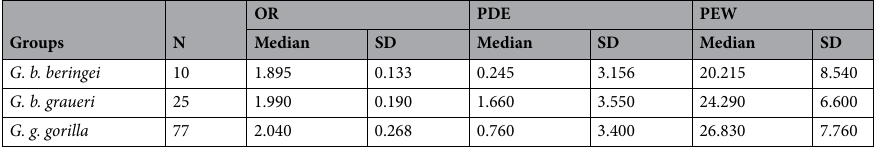
Table 3. Summary statistics (median and SD) of occlusal relief index (OR), percentage of dentine exposure (PDE) and percentage enamel wear (PEW).